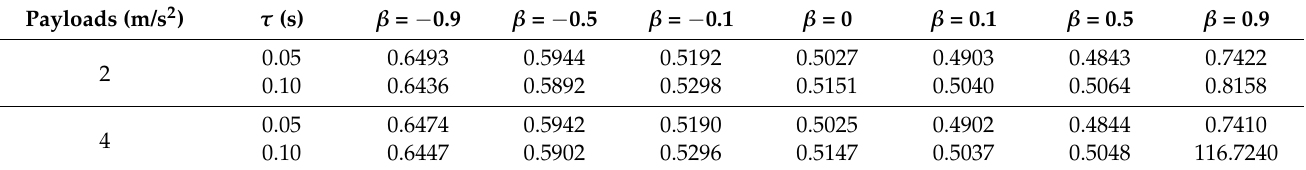
Table 13. Root mean squared error (RMSE) of the simulated tracks under different payloads, different input time delays and different fractional orders in the proposed controller.